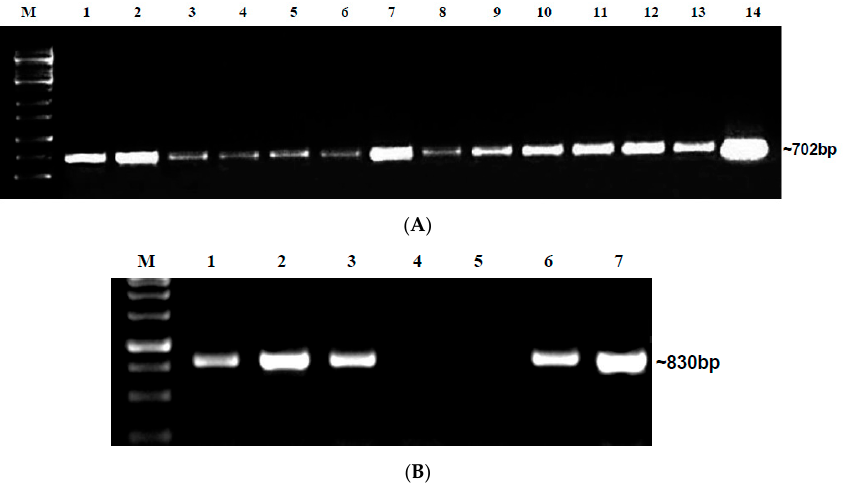
Figure 5. ( A ) Detection of ToLCNDV in grow-out test leaf samples from microplot I. M—1 Kb ladder; L1 to 13 grow-out test leaf samples—ToLCNDV, L14—PC. ( B ) Detection of BgYMV in grow-out test plants in microplot I. M—1 Kb ladder; L1 to 6—Grow-out test leaf samples-BgYMV, L7— PC.